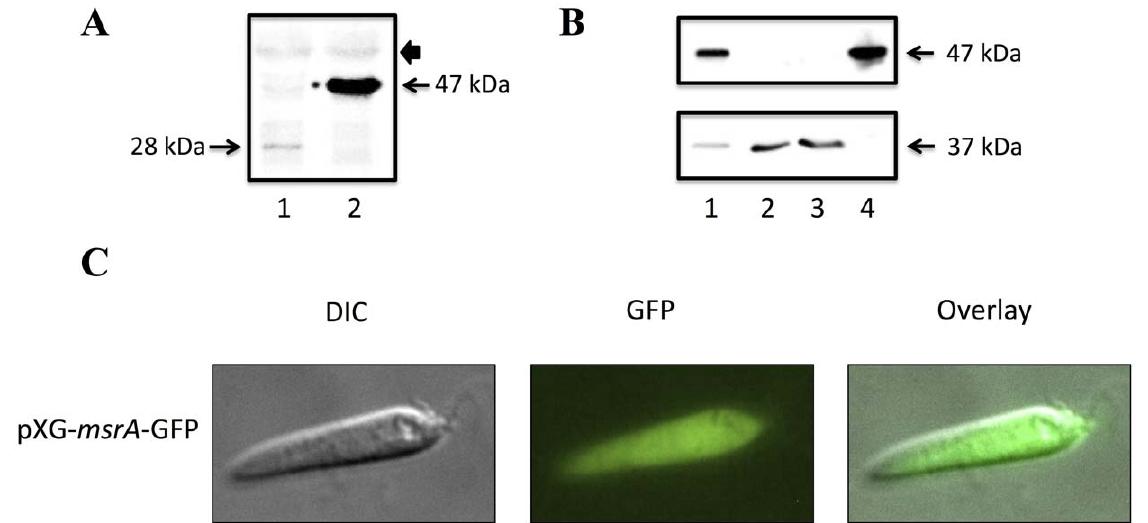
Figure 2. Subcellular localization of MsrA-GFP. A. Whole cell lysates of L. major transfected with pXG-‘GFP alone (Lane 1) or with pXG- msrA -GFP (lane 2) were analyzed by SDS-PAGE and proteins detected by Western blot using the anti-GFP antibody. Approximate molecular weights are as indicated. Cells transfected with pXG-‘GFP alone express a 28 kDa band corresponding to GFP alone, whereas cells transfected with pXG- msrA -GFP express the 47 kDa MsrA-GFP fusion protein. Similar non-specific cross reaction with a higher molecular weight band (arrow head) indicates equal sample loading. B. L. major promastigotes transfected with pXG- msrA -GFP were lysed and subjected to differential centrifugation. Fractions were probed with anti-GFP (top panel), then reprobed with anti-FBP (bottom panel) to confirm the integrity of organelles following cell lysis. Lane 1, whole cell lysate; Lane 2, 10,000 6 g organelle fraction; Lane 3, 100,000 6 g microsomal fraction; Lane 4, supernatant (cytosolic) fraction. LmMsrA-GFP is present only in whole cells and the cytosol. The glycosome enzyme, FBP, was only detected in the total extract and in the organelle and microsomal fractions confirming the integrity of the organellar fraction. C. Epifluroscent microscopy images of L. major promastigotes infected with pXG- msrA - GFP constructs. Cytoplasmic green fluorescence is seen in the parasites expressing the LmMsrA-GFP fusion